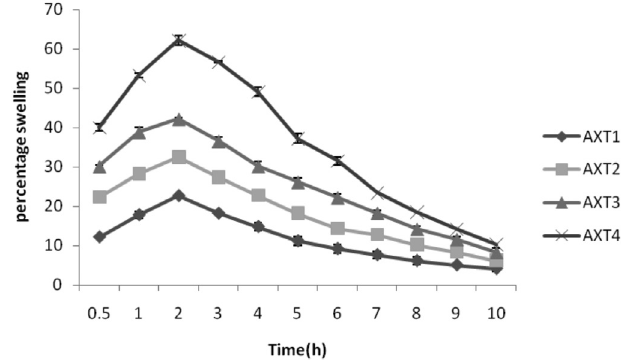
FIGURE 3 - Percentage swelling of aceclofenac-xanthan gum tablets (AXM 1 to AXM 4).